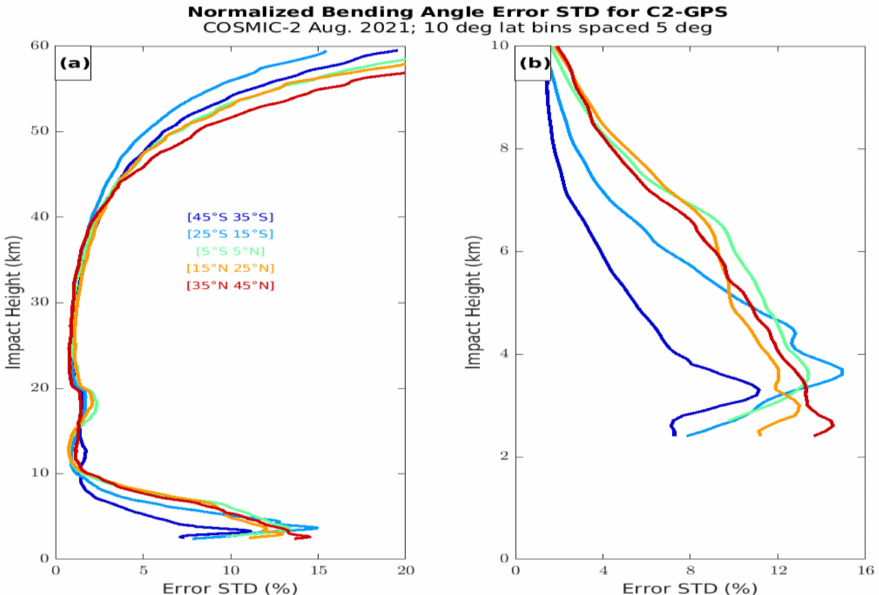
Figure 10. 3CH estimates of bending angle error STD for C2 (GPS) for August 2021 by 10 ◦ latitude